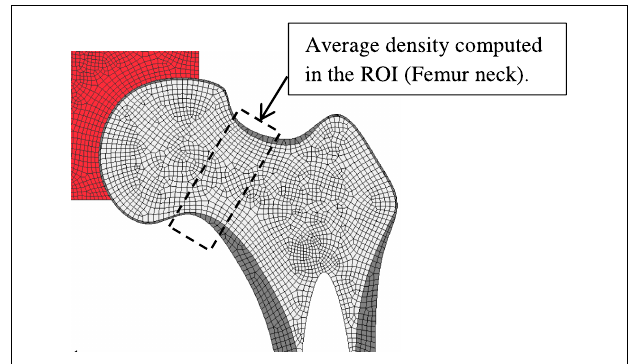
FIGURE 5 | Region of interest (ROI) where the variation of bone density is computed for the sensitivity analysis